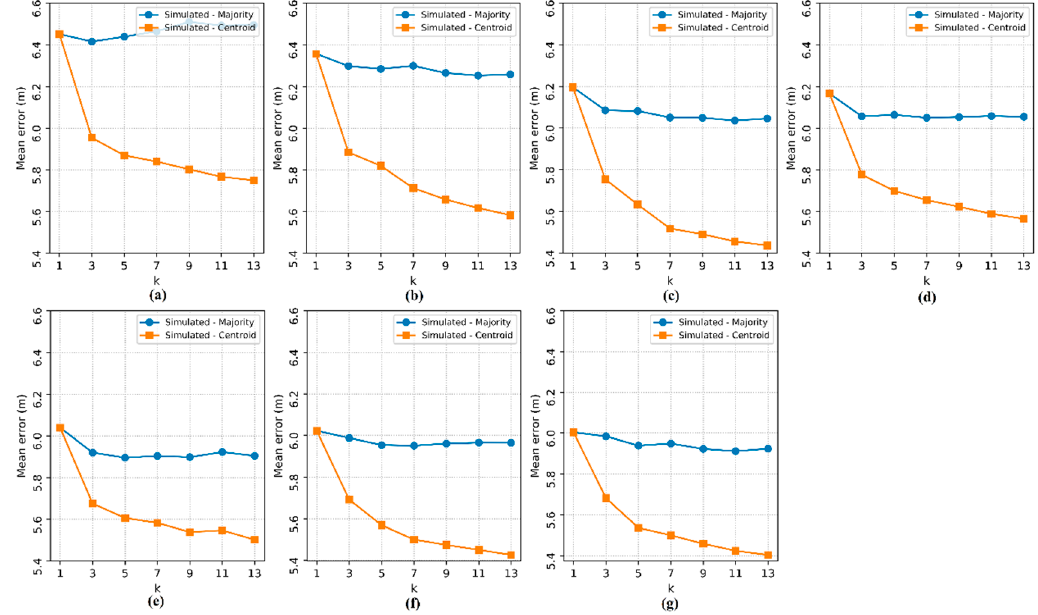
Figure 14. Localization mean error in the simulated environment with an area of 56 m × 56 m. The subfigures show the tests for each number of access points: ( a ) 2 APs, ( b ) 3 APs, ( c ) 4 APs, ( d ) 5 APs, ( e ) 6 APs, ( f ) 7 APs and ( g ) 8 APs.